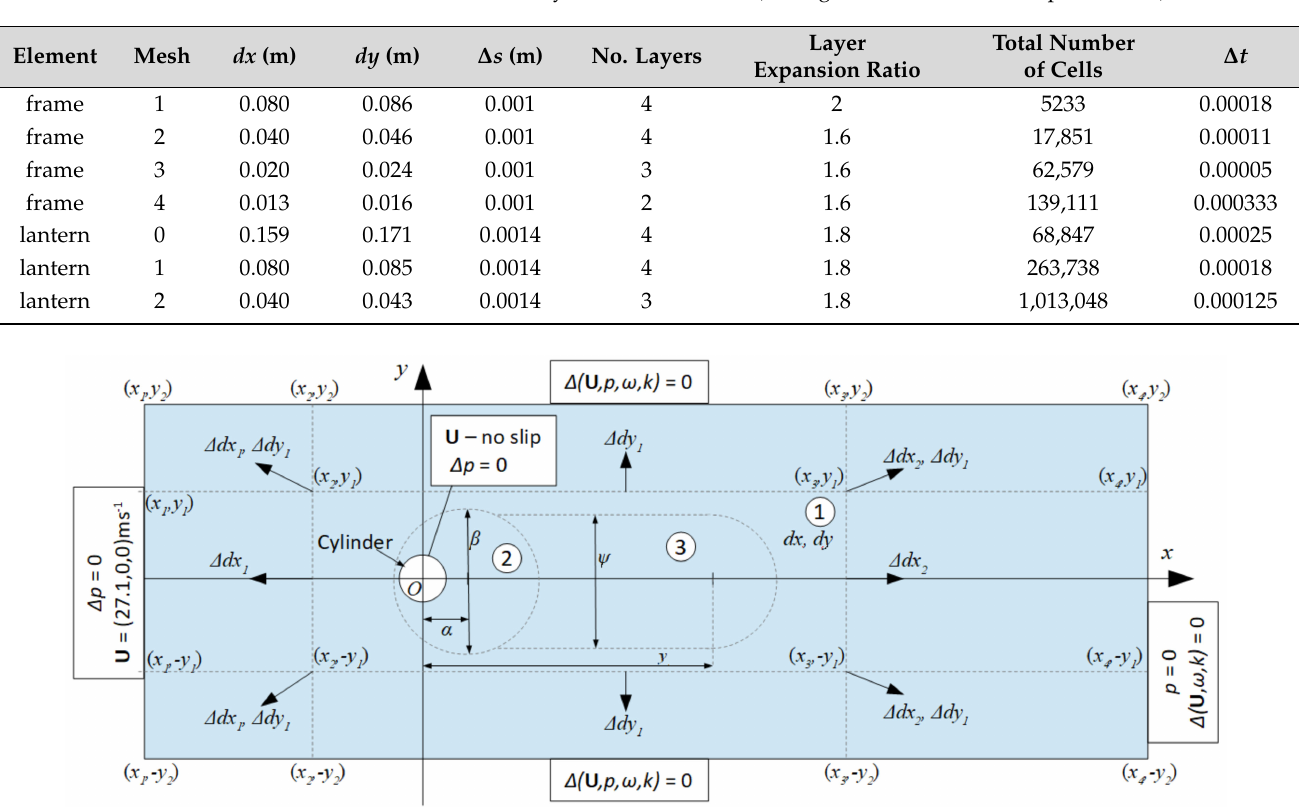
Table 1. Parameters describing the mesh resolution, near-wall layers and timestep for each mesh used in simulations of cylinders in isolation (see Figure 5 for definition of parameters).